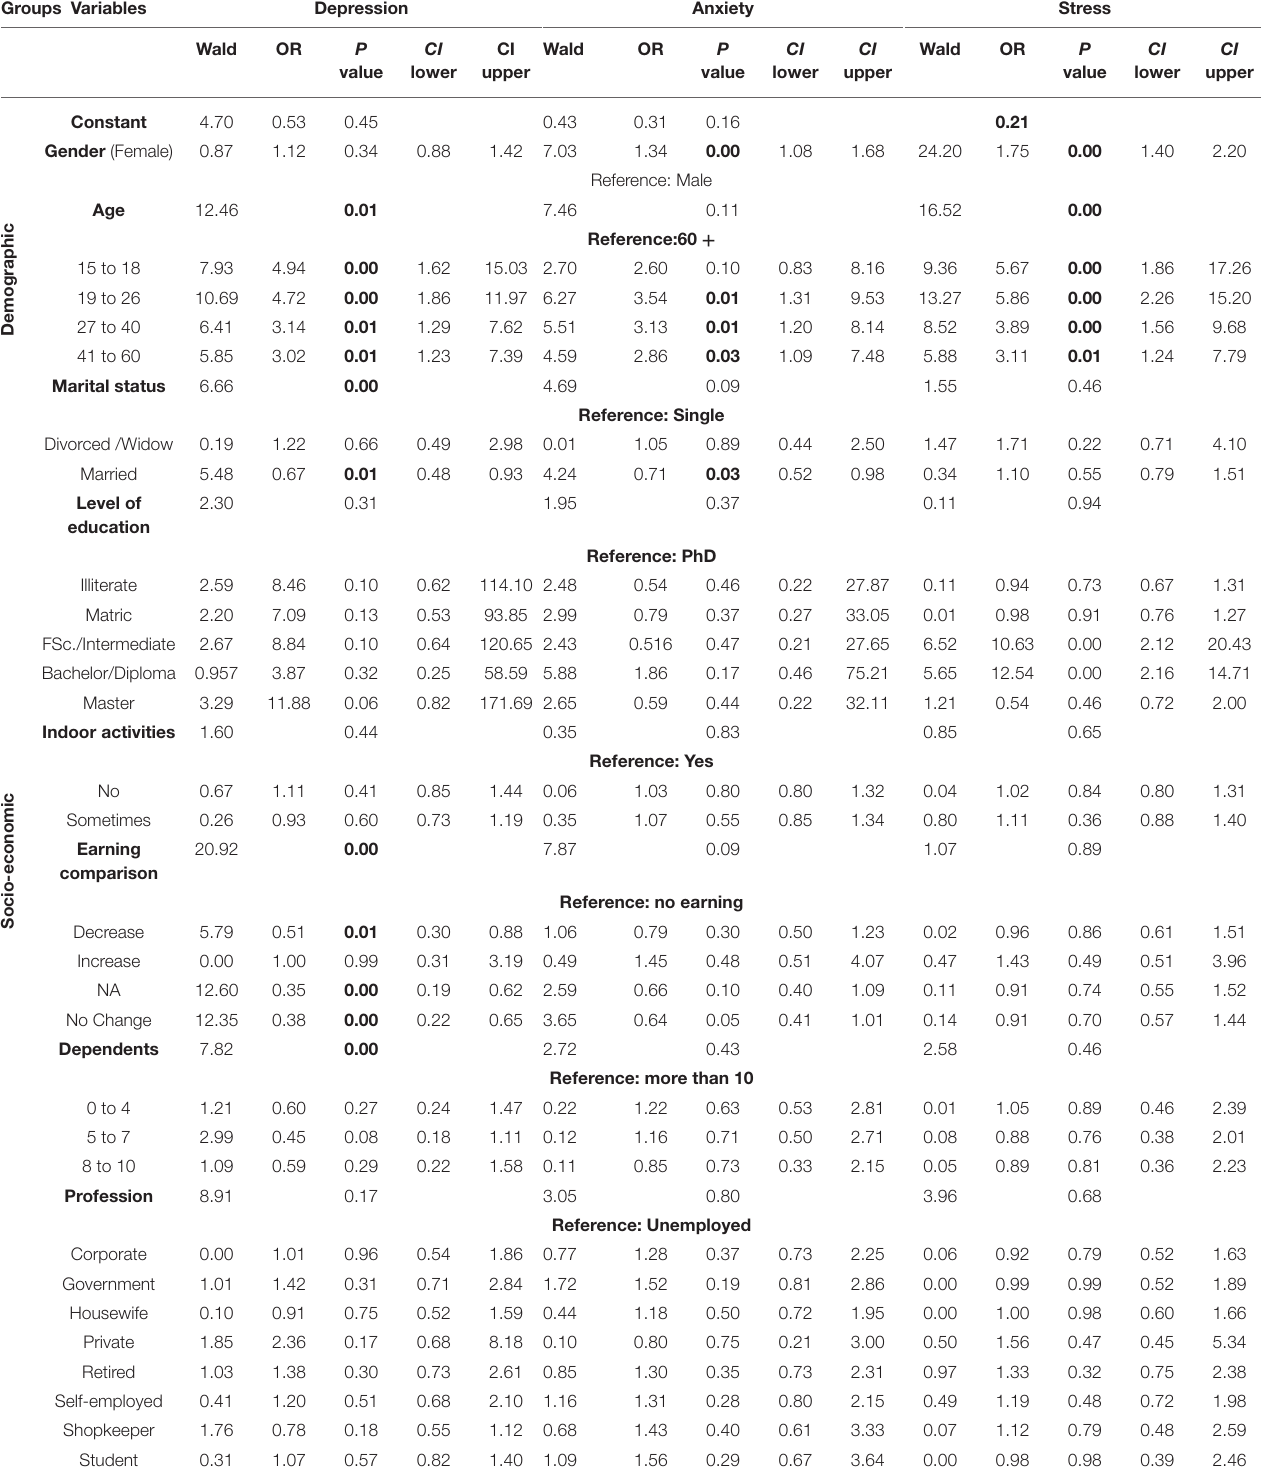
TABLE 3 | Determinants of depression, anxiety, and stress identified with binary logistic regression. Groups Variables Depression Anxiety Stress